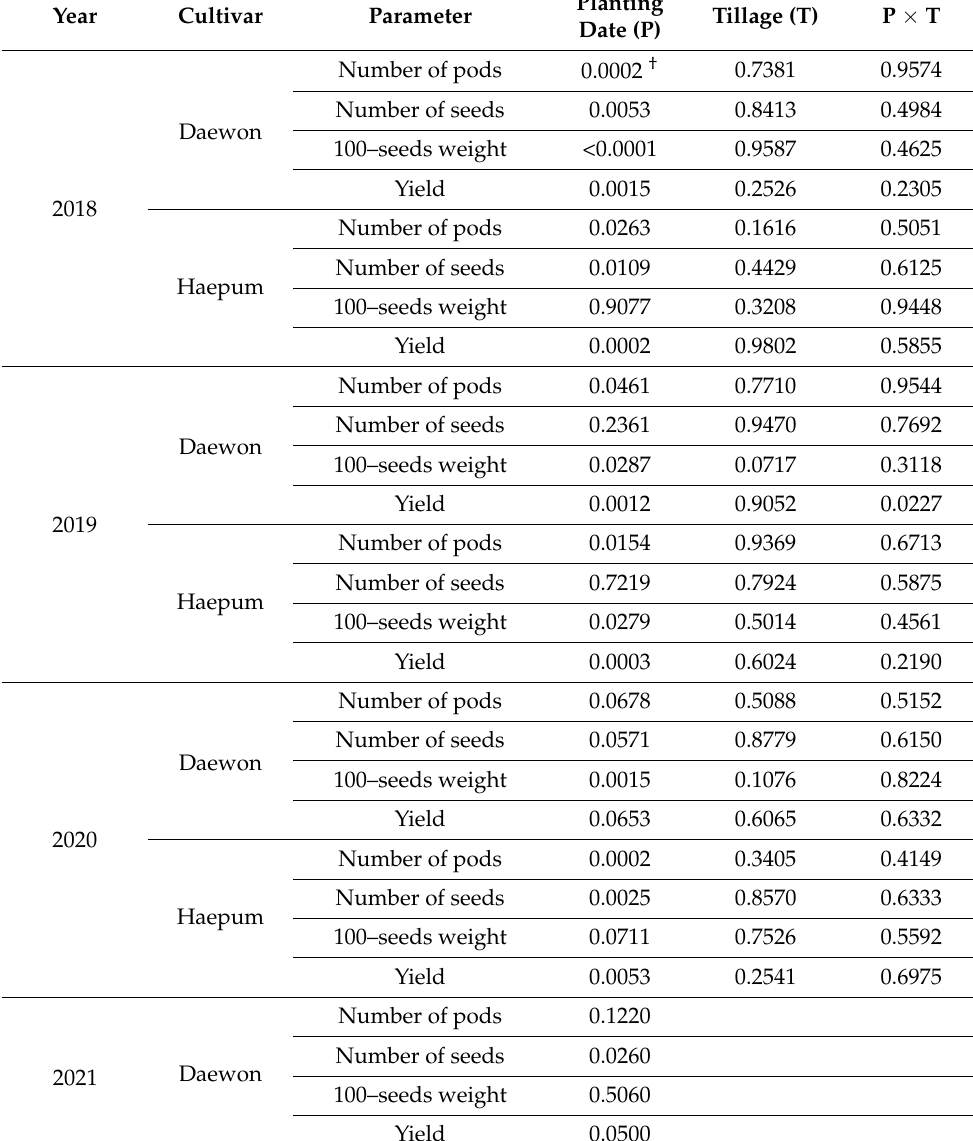
Table 11. Statistical analysis ( p -value) of yield and yield components of two soybean cultivars (Daewon and